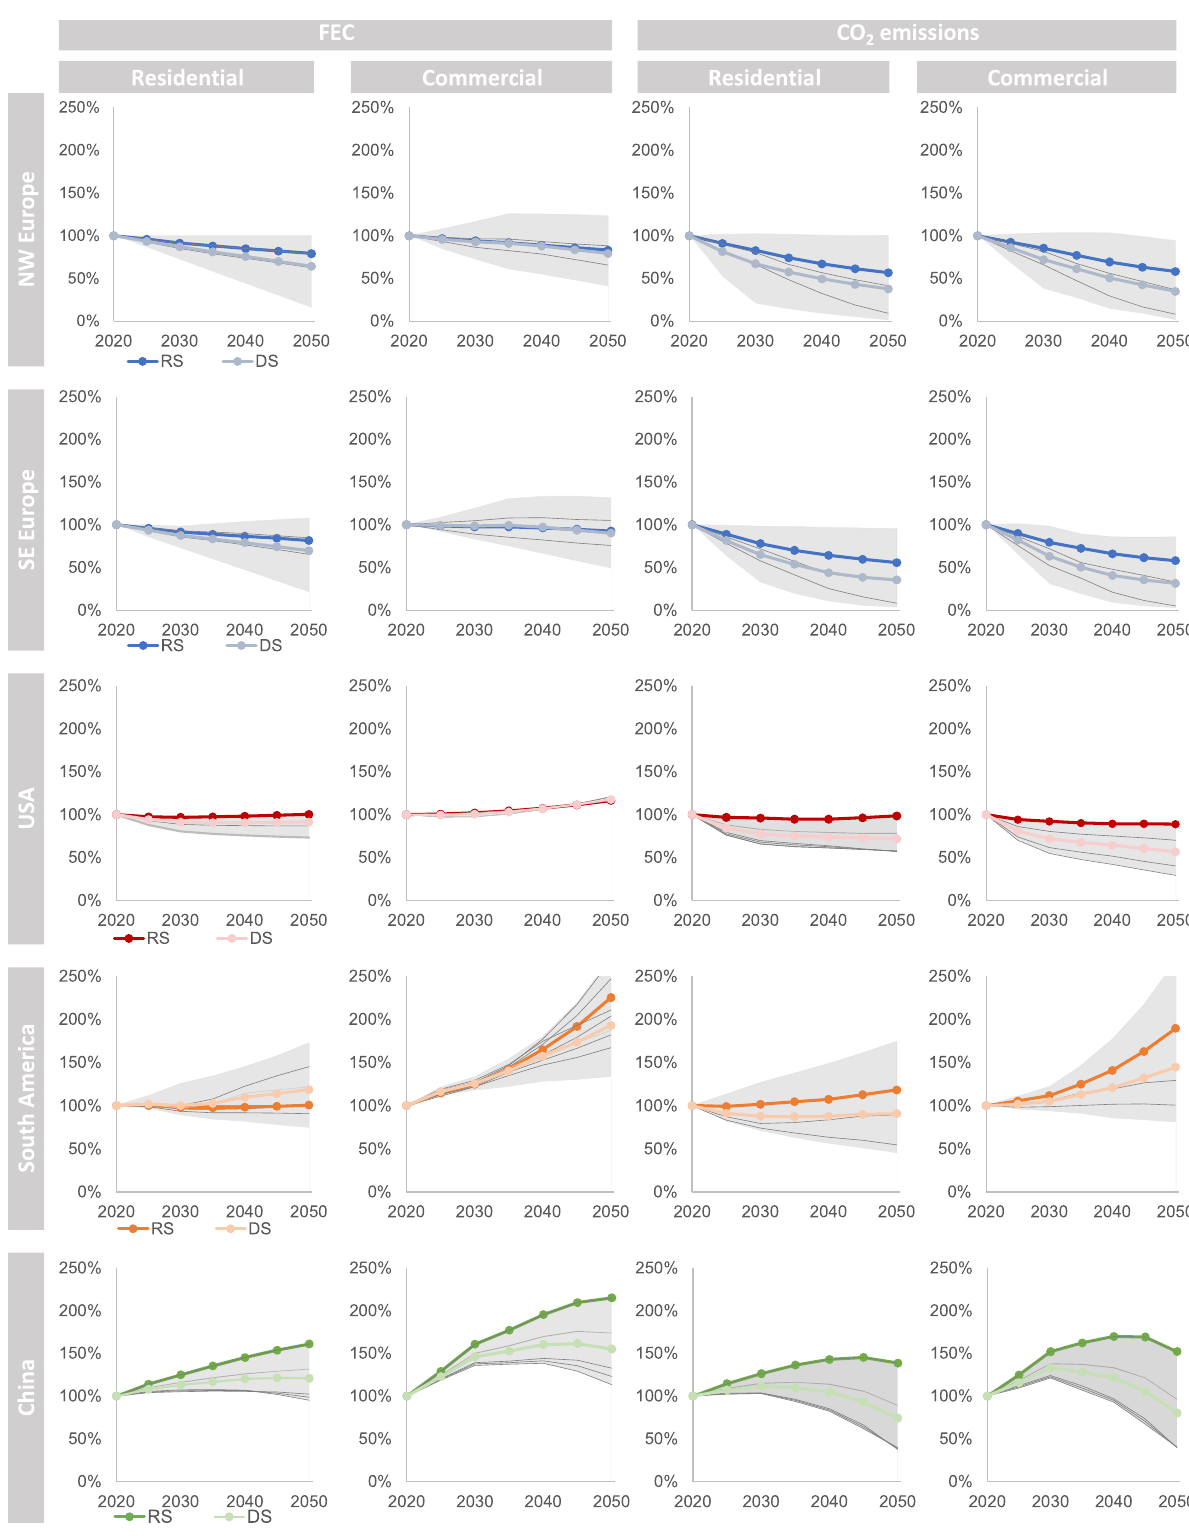
Fig. 2 Annual FEC and CO 2 emissions in residential and commercial subsectors region-wise (NW and SE Europe, South America) and country-wise (USA and China) in the reference scenario (RS) and decarbonization scenarios (DSs) until 2050, shown as percentages of the corresponding value in 2020. The gray area shows the range of values between the minimum and maximum from both the RS and DSs across the regions.